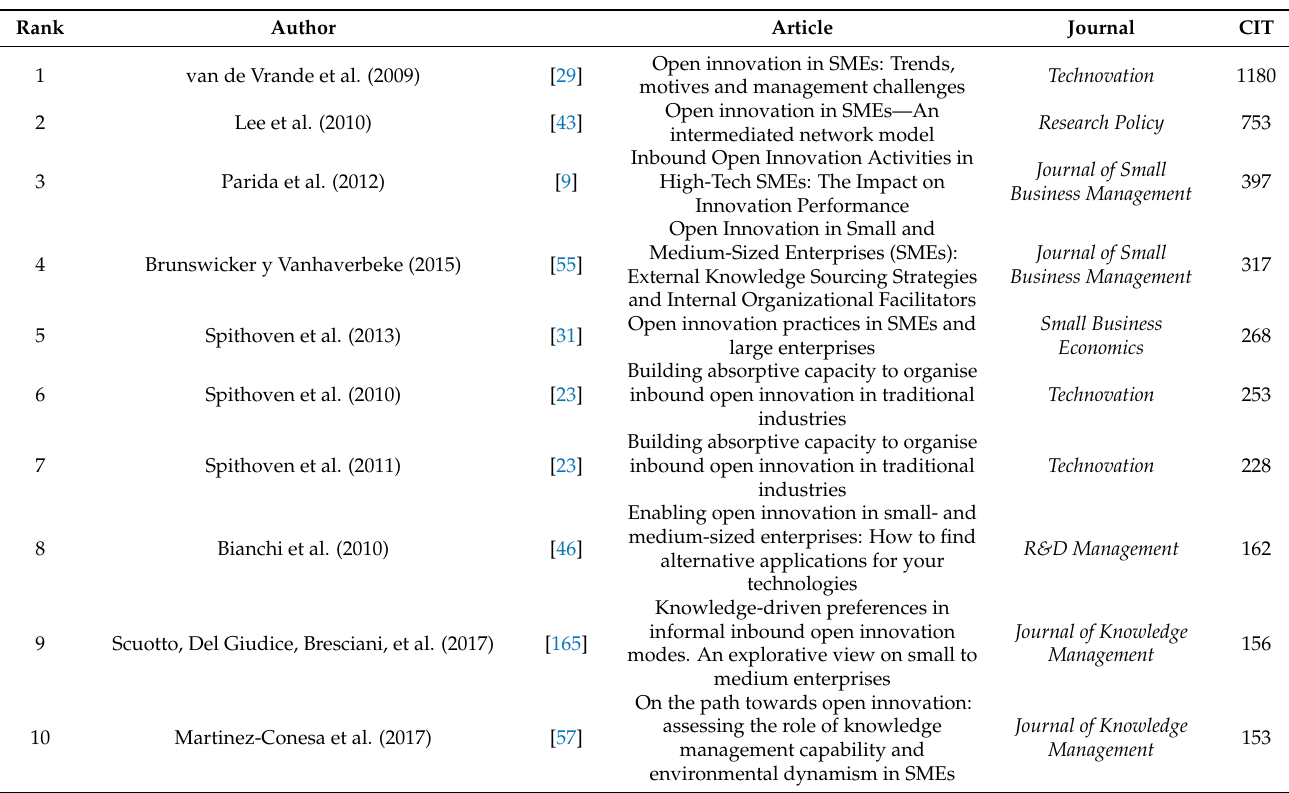
Table 3. Most cited